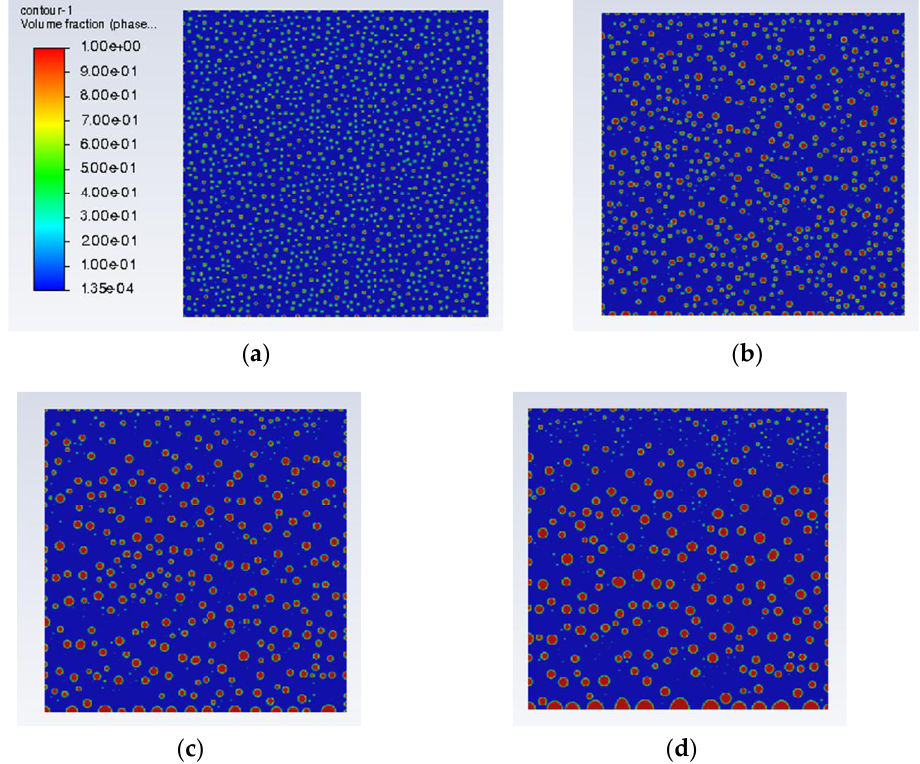
Figure 8. Droplet distribution of dropwise condensation with θ = 90°: ( a ) t = 0.2 s; ( b ) t = 0.4 s; ( c ) t = 0.6 s; ( d ) t = 0.8 s.